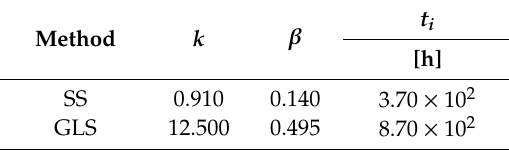
Figure 10. Relaxation modulus: ( a ) standard sigmoid (SS) x EPL models; ( b ) generalized logistic sigmoid (GLS) x EPL models. Table 7. Parameters to obtain relaxation modulus by EPL expression.